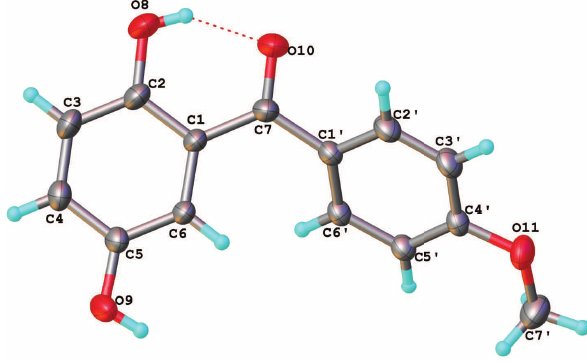
Table 1: Data collection and handling.